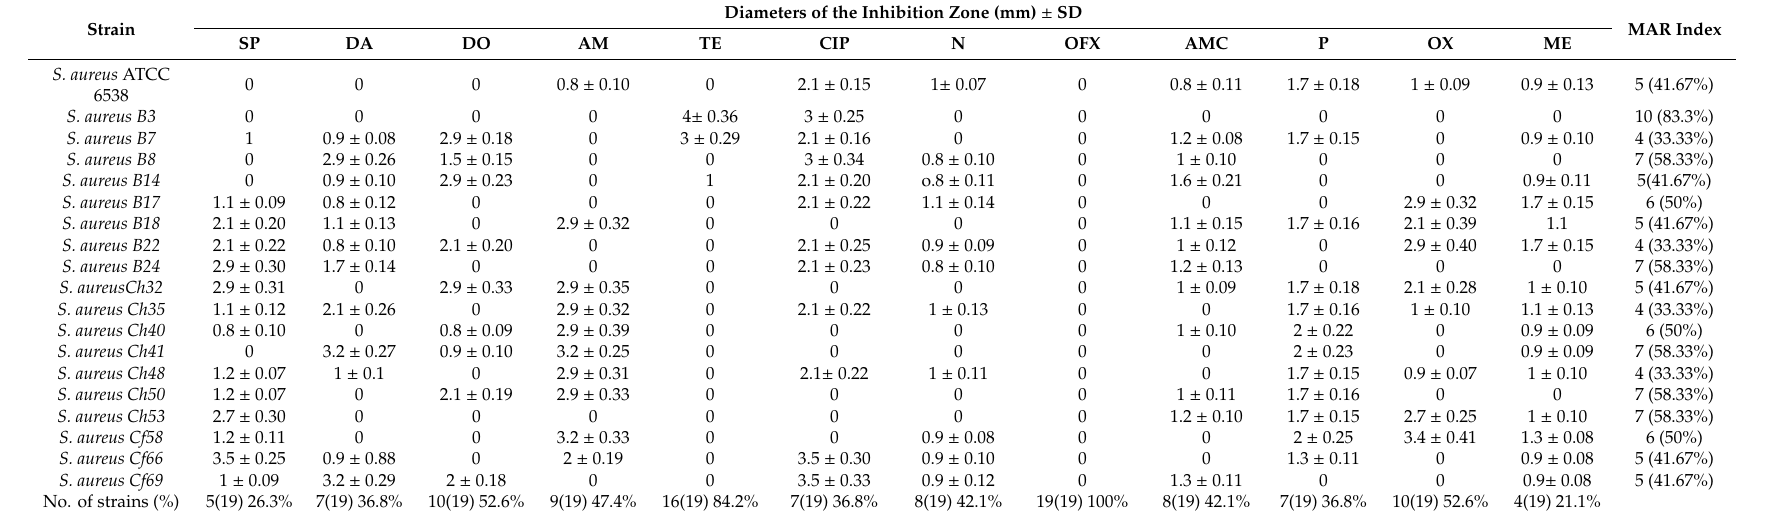
Table 1. Antibiotic sensitivity test of the studied bacteria based on the diameter of inhibition zone